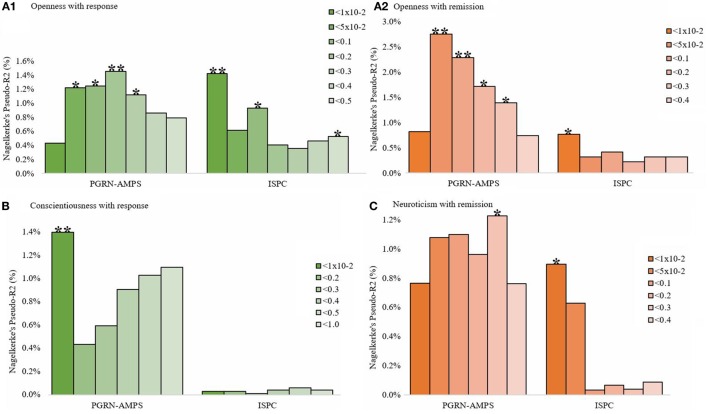
The bar graphs (A–C) show the association of the PGSs for the Big Five personality traits with SSRIs response or remission at different p-value thresholds (PT) after 4 weeks of treatment in the PGRN-AMPS (n = 529) and ISPC (n = 865) samples. The y-axis (Nagelkerke’s Pseudo-R2) refers to the percentage of variance in SSRIs treatment response/remission accounted for the PGSs of the Big Five personality traits at a particular PT in each sample. On the x-axis, plotted from left to right, are the GWAS PT for personality traits used to group the SNPs for the PGSs. The *sign on the top of each bar signify the statistical significance of the PGS association as *p < 0.05, **p < 0.01, ***p < 0.001. Abbreviations: PGRN-AMPS, the Pharmacogenomics Research Network Antidepressant Medication Pharmacogenomic Study; ISPC, the International SSRI Pharmacogenomics Consortium study; SNP, single nucleotide polymorphism; PGS, polygenic score; SSRIs, selective serotonin reuptake inhibitors.